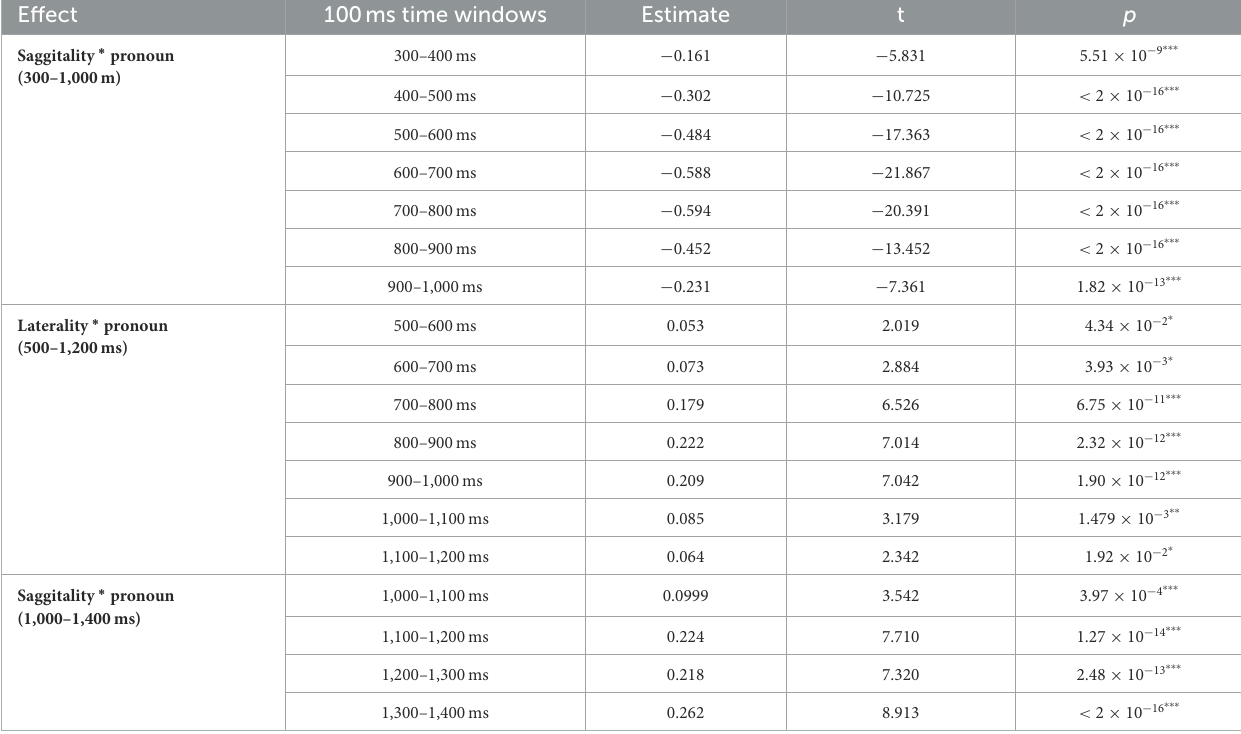
TABLE 1 Summary of significant interactions in the main time windows.